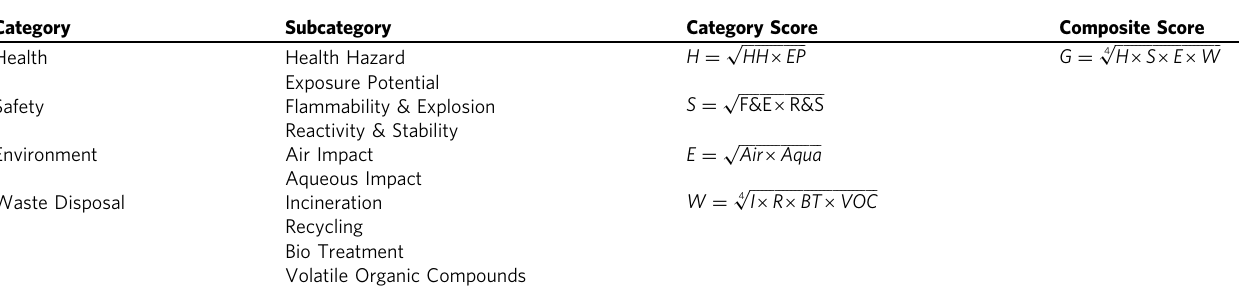
Table 1 The solvent sustainability categories and subcategories in the GSK solvent sustainability guide and the method for the calculation of the composite